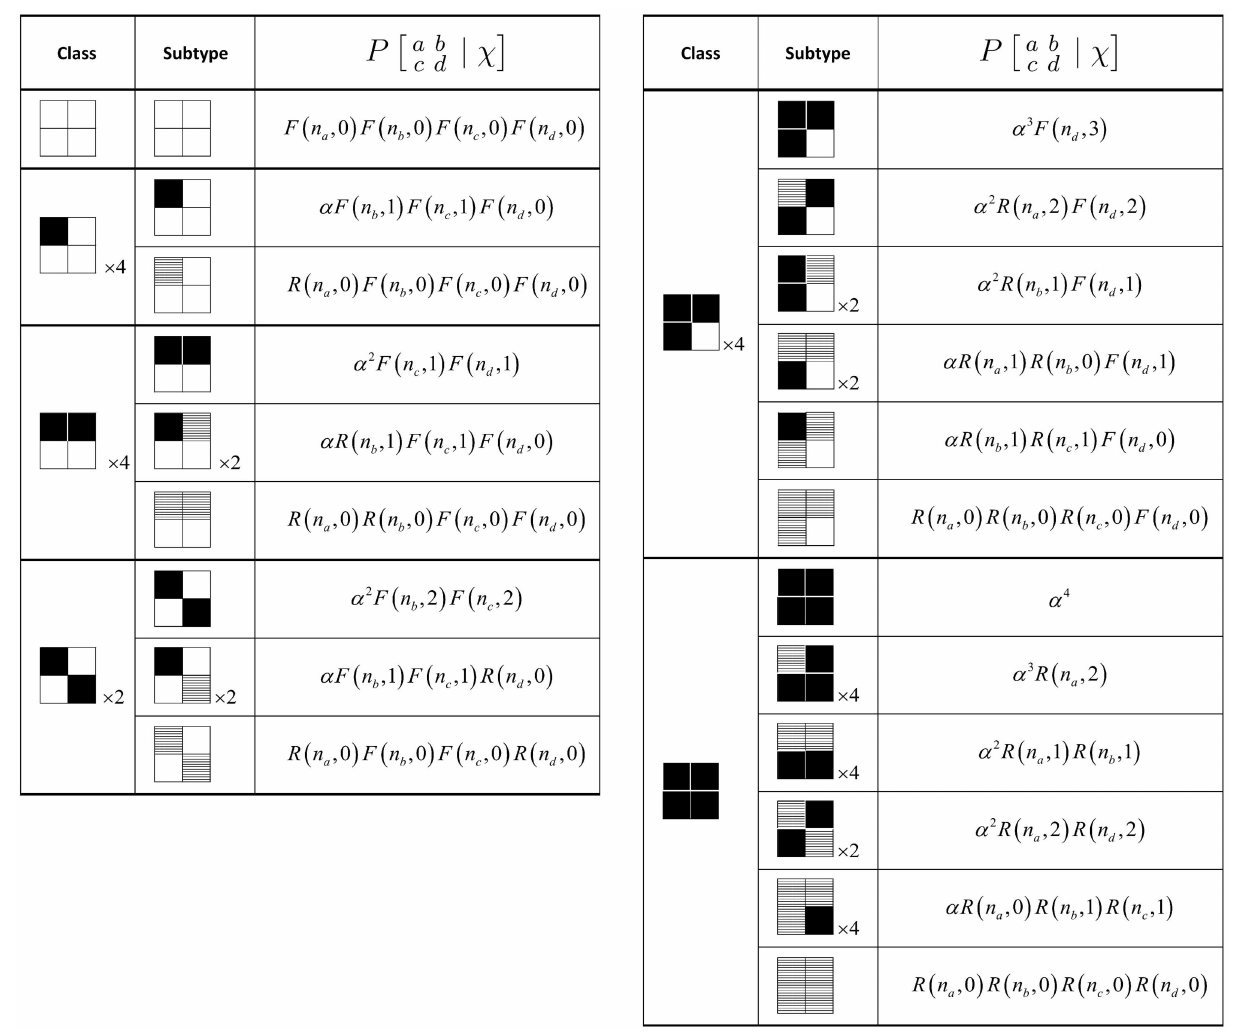
FIGURE 8 | Production probability calculations for the quartet configurations. Site states are inactive (white), self-activated (black), or recruited (hatched). Functions R ( n , j ) and F ( n , j ) are as defined in the text. The available neighbor counts n a through n d are determined for each specific configuration of χ . The symmetry multipliers apply either to an entire class or a single